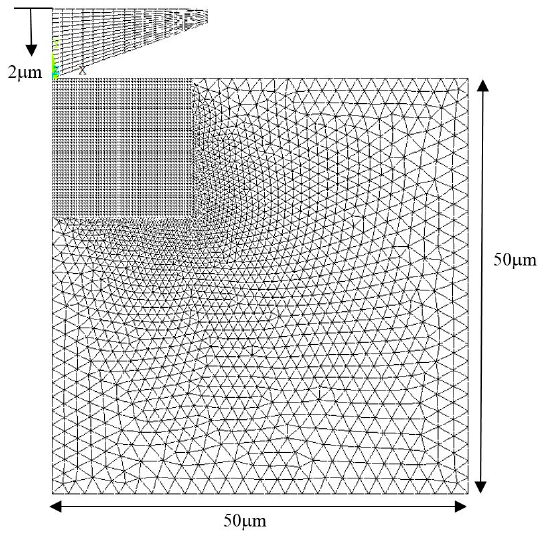
Figure 2. Nanoindentation finite-element model.